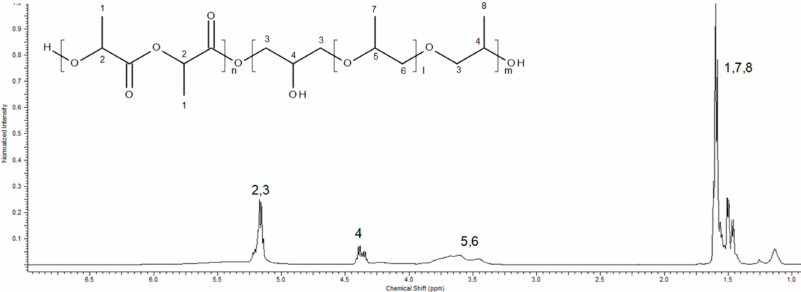
Figure 4. 1 H NMR spectrum of PLA- co -PPGDGE with monomer ratio 80/20.